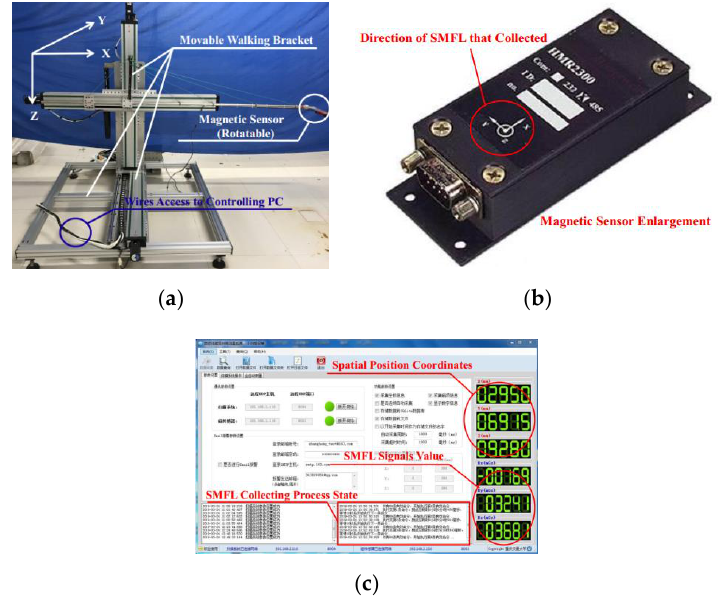
Figure 4. The self-magnetic flux leakage (SMFL) signal automatic acquisition device. ( a ) Overall equipment, ( b ) magnetic sensor enlargement, and ( c ) PC-side operating software interface.